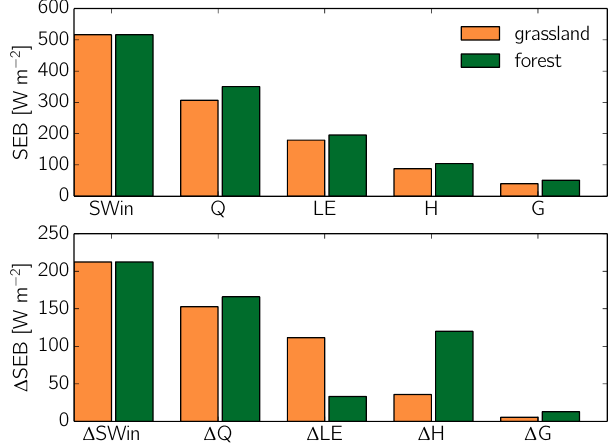
Figure 3. The surface energy balance (SEB) under normal condi- tions (top panel) and under heat wave conditions (bottom panel) as computed in the modeling experiment. The values are the 10h means over the entire duration of the model run. The difference is computed by subtracting the mean state from the heat wave condi-